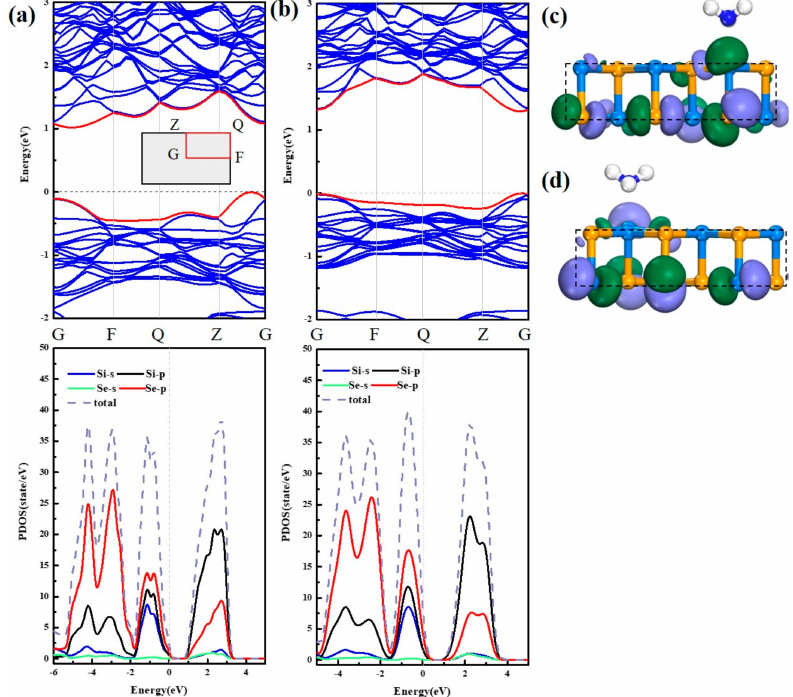
Figure 8. The band structure and PDOS of ( a ) NH 3 / SiSe systems and ( b ) 8% tensile stress-NH 3 / SiSe systems, respectively. The inset of ( a ) is the Brillouin Zone path. The Fermi level (the dash line) is set to zero. ( c ) HUMO and ( d )